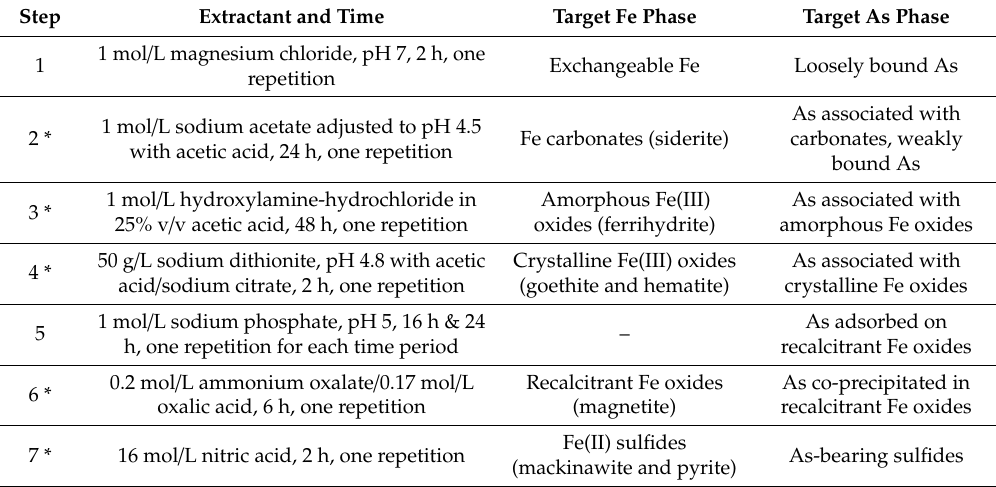
Table 1. Sequential extraction procedure applied to sediment samples collected in 2018 (modified from Sun et al.